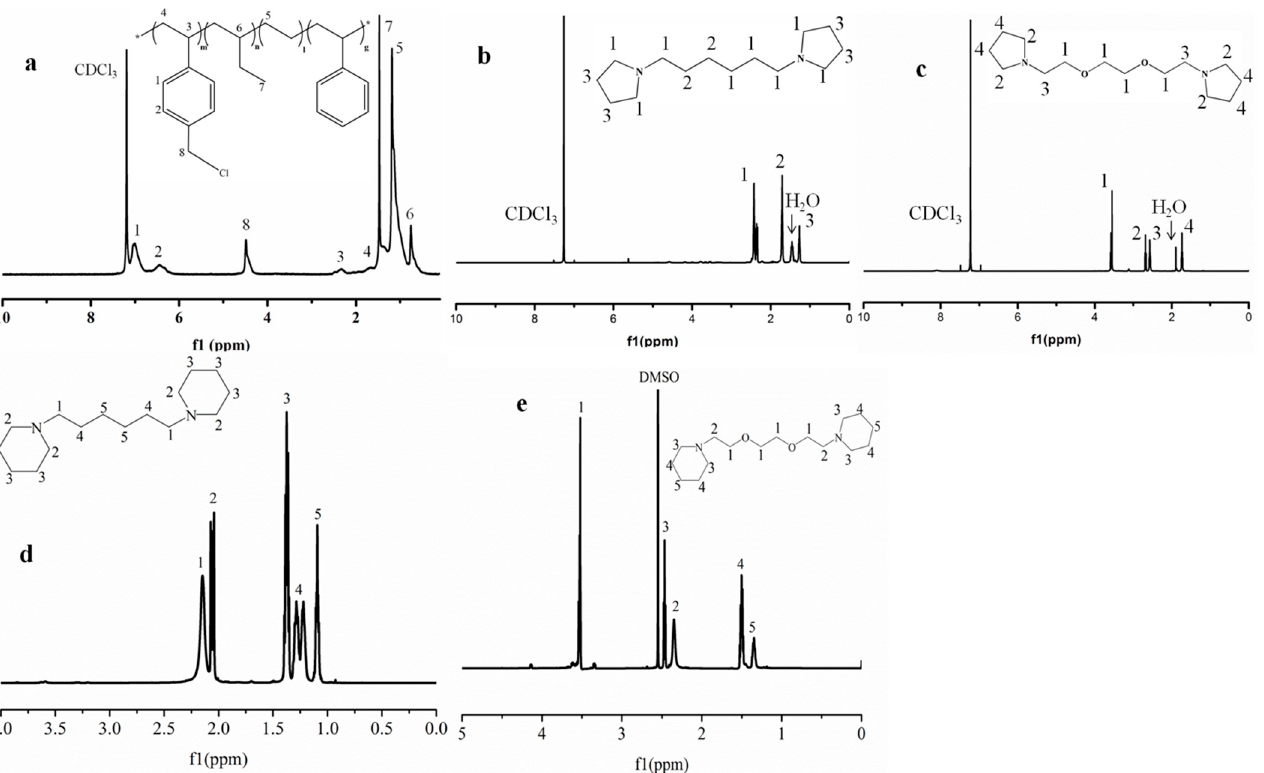
Figure 1. ( a ) 1 H NMR spectrum of cmSEBS; ( b – e ) 1 H NMR spectra of Py2C6, Py2O6, P2C6, and P2O6.